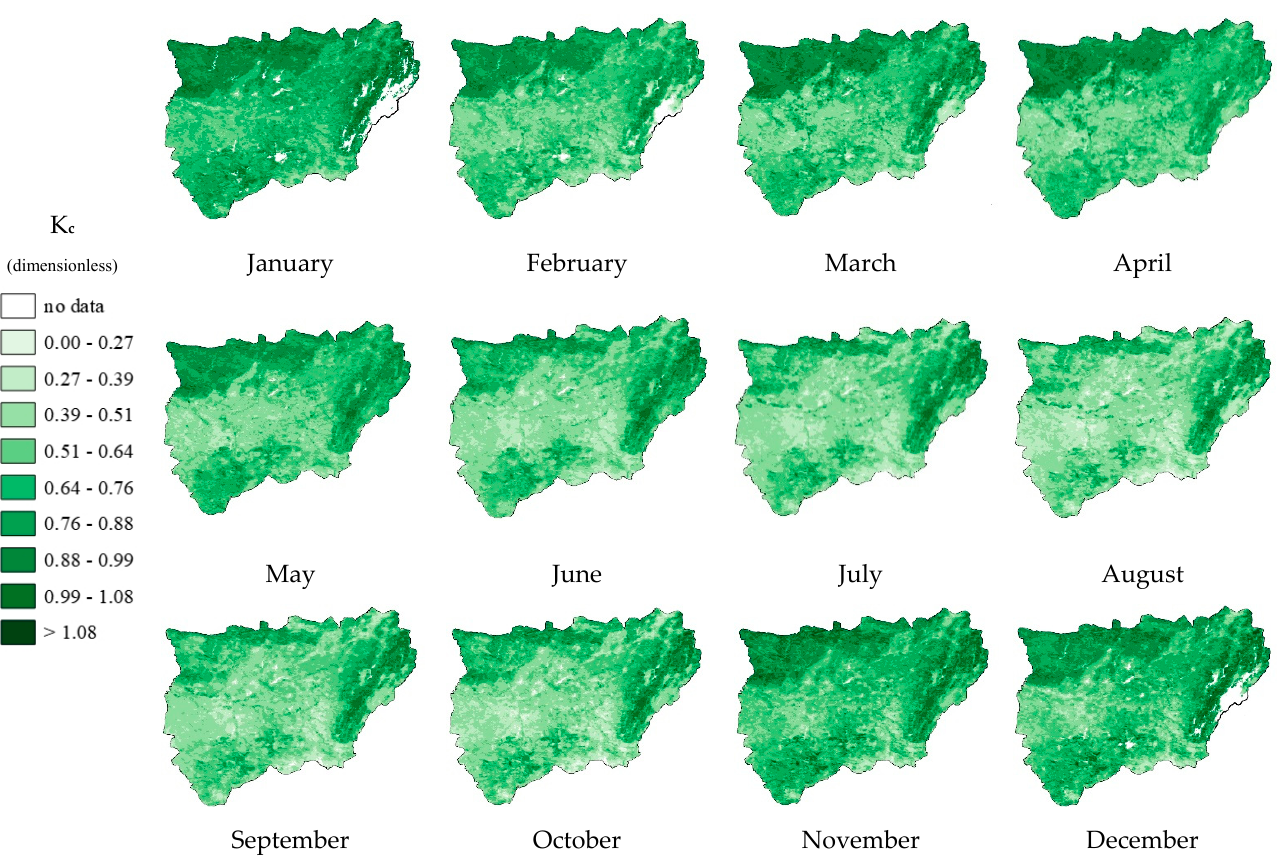
Figure 9. Monthly variation in K c . (The scale of color is presented on the left of the figure). The monthly evolution of crop evapotranspiration (ET c ) is presented in Figure 10. However, great variability for ET c values was found in the study area throughout the season. All the regions presented extremely high ET c values, mainly from May to August (more than 80 mm). ET c values lower than 50 mm were found from October, but even in this month, some regions presented some data of approximately 80 mm. During the period of the greatest values (from May to August), the north-west and east zones presented the maximum ET c .